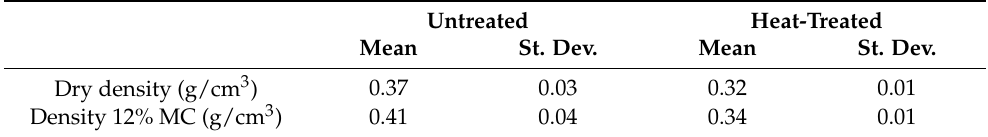
Table 3. Density of untreated and heat-treated ayous wood. Untreated Heat-Treated Mean St. Dev. Mean